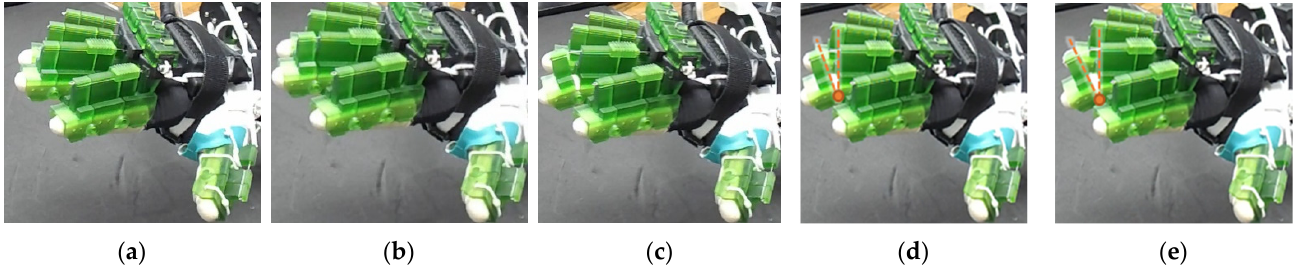
Figure 15. Isolated DIP flexion of middle finger: ( a ) hand is at extended position, DIP joint angle: 0°; ( b – d ) intermediate DIP joint positions; and ( e ) DIP joint angle: 35°.